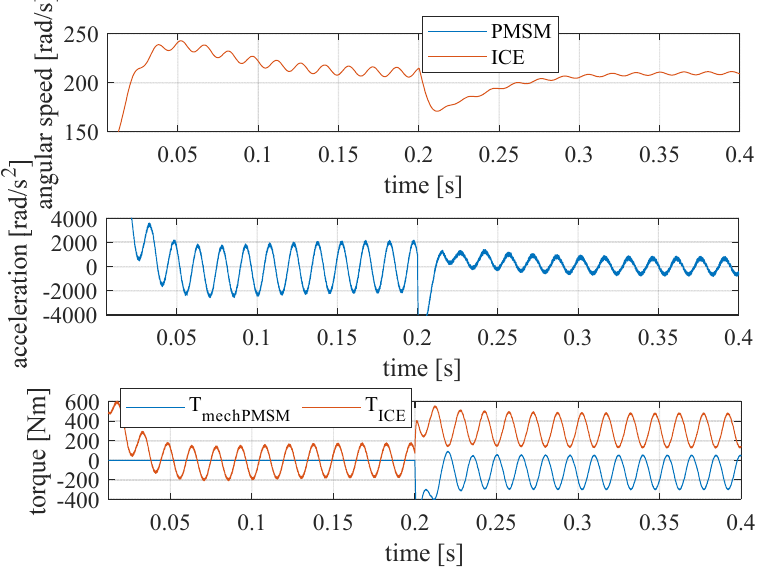
Figure 20. Speed, angular acceleration and torques when PMSM loaded ICE engine as generator.